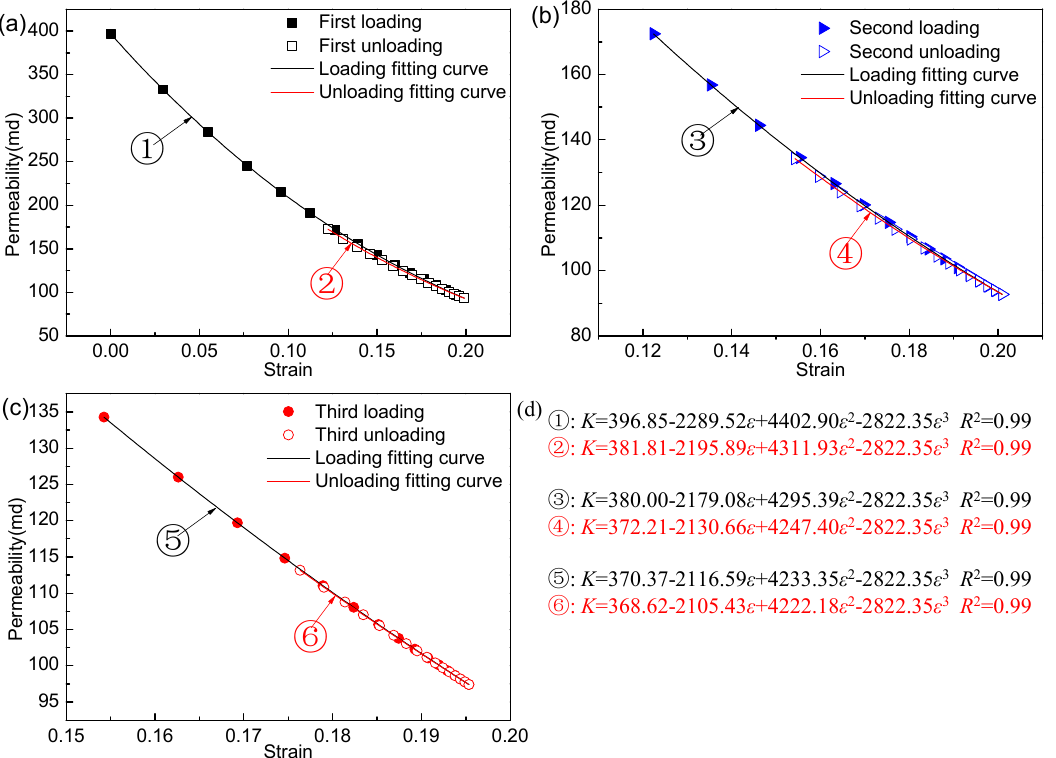
Figure 14. Relation curve between permeability and strain under cyclic loading and unloading conditions of broken coal samples: ( a ) the first cyclic loading and unloading, ( b ) the second cyclic loading and unloading, ( c ) the third cyclic loading and unloading, ( d ) the fitting formulas between permeability and strain.